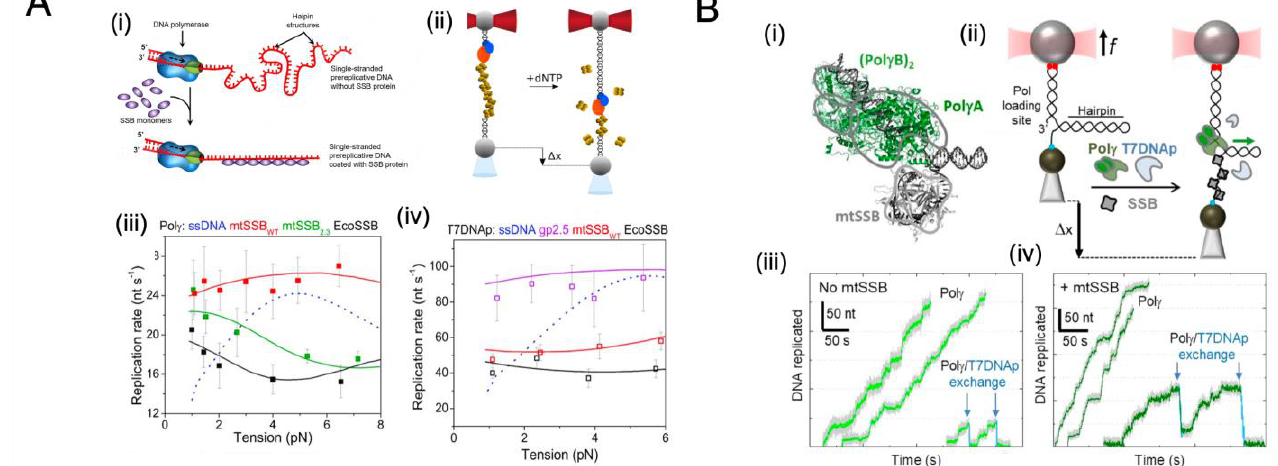
Figure 6. Single-molecule studies on SSB interacting with DNA polymerase during replication and strand exchange. ( A ) The effect of SSB proteins on DNA replication is shown in (i). SSBs bind to intermediate single-stranded DNA (ssDNA) during replication to prevent secondary structure formation and promote polymerization. However, the pre-bound SSB must be displaced for DNA polymerase to synthesize ssDNA into double-stranded DNA (dsDNA). Image adapted from [173]. The optical tweezer plus micropipette method used to measure replication is illustrated in (ii). The DNA polymerase binds to the primer template’s 3 (cid:48) ends, while SSB coats the ssDNA portion. In the presence of deoxynucleoside triphosphates (dNTPs), polymerization causes SSB release, as seen by the extension of the DNA template. The maximum rate (Vmax, in nt s − 1 ) of Pol γ is shown in (iii) to be dependent on tension in the presence of various SSBs (mtSSB, E. coli SSB). Solid lines represent the best fit of the data with Equation (4) in [172] for quantifying the energetics of the polymerase– SSB interactions necessary for SSB displacement. As a reference, the dotted blue line indicates the fit to Vmax of the SSB-free ssDNA. The Vmax of T7 DNAp in the presence of different SSBs is depicted in (iv). Solid lines show the best fit of the data with Equation (4) in [172] to compare the homologous and non-homologous effects. As a reference, the dotted line shows the fit Vmax of T7DNAp in the absence of SSB. Images adapted from [172], under the terms of the Creative Commons Attribution Non-Commercial License (http://creativecommons.org/licenses/by-nc/4.0/, accessed on 17 December 2022), Copyright © The Author(s), 2019. ( B ) The interaction between Pol γ (PDB 3IKM [174]) and mitochondrial SSB (PDB 3ULL [175]) during strand displacement synthesis is shown in (i). The optical tweezer plus micropipette method used to investigate strand displacement synthesis by Pol γ and T7DNAp is demonstrated in (ii) [176,177] (iii) Representative traces of Pol γ (2 nM) in the absence (left) and presence (right) of competing T7DNAp served as a control. (iv) Representative traces of Pol γ (2 nM) activity in the presence of cognate mtSSB without (left) and with (right) competing T7DNAp. Images adapted from [177] under a CC-BY-NC-ND 4.0 International